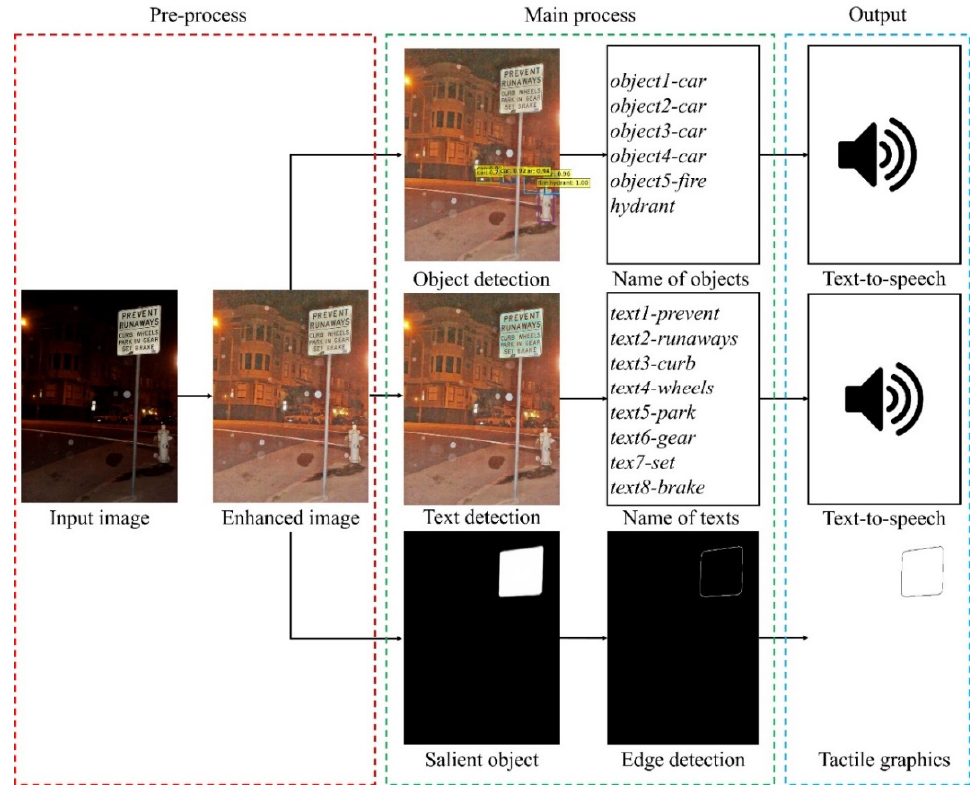
Figure 3. The main steps of the proposed system.